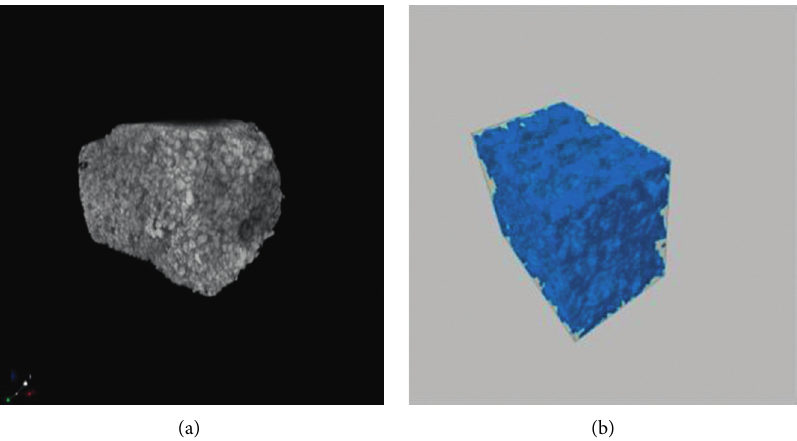
Figure 4: Porosity analysis of the composite using µ CT analysis of the porosity of the composite (a). 3D models were created and a volumetric analysis of the porous was performed (b).